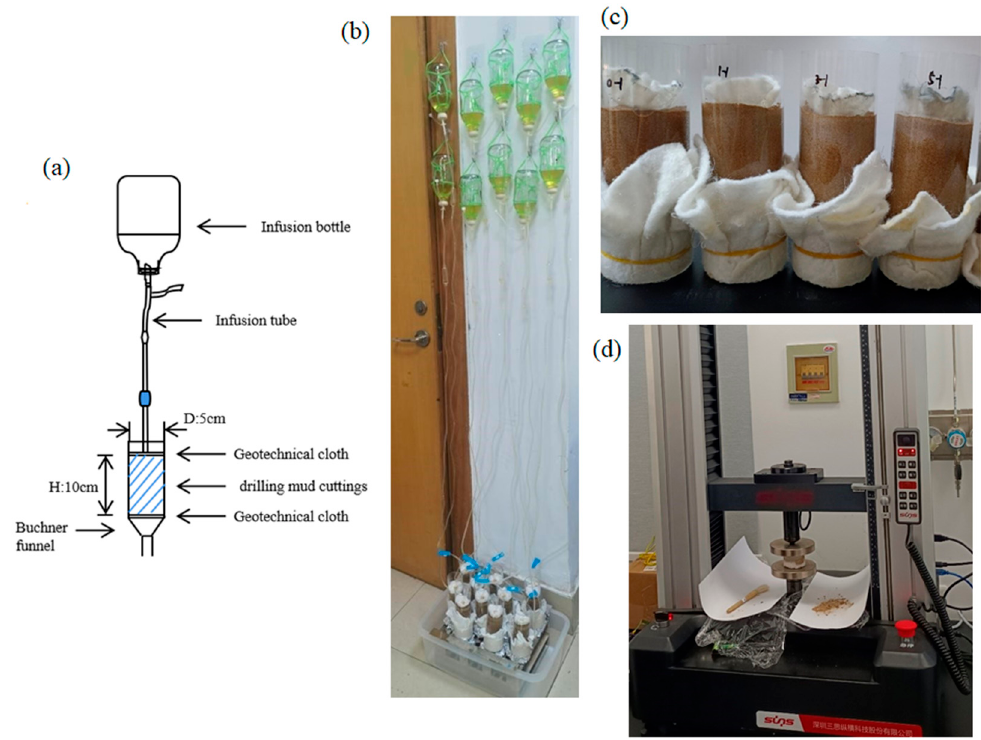
Figure 1. ( a ) Schematic of the experimental setup, ( b ) photo of the grouting equipment, ( c ) sand samples treated with MICP for six days, ( d ) the unconfined compression tester. samples treated with MICP for six days, ( d ) the unconfined compression